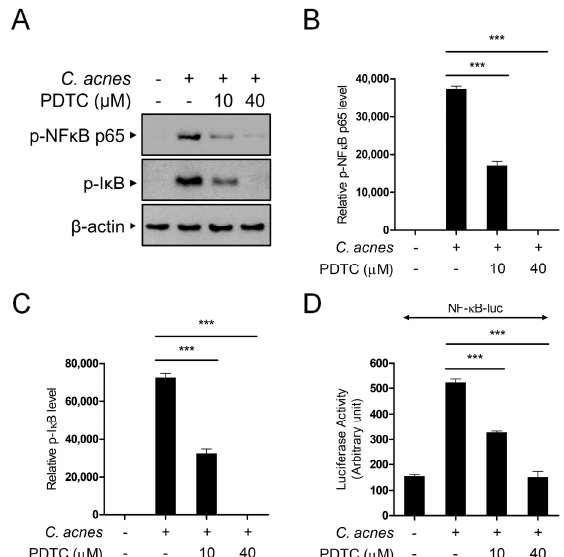
Figure 3. PDTC suppresses C. acnes -induced NF- κ B transcriptional activation. ( A – C ) Mouse BMDMs were pretreated with PDTC (10 µ M and 40 µ M) for 30 min and then incubated with heat-killed C. acnes (1 × 10 6 CFU/mL) for 30 min. p-NF- κ B (p65), p-I κ B, and β -actin protein levels were detected by Western blot analysis ( A ), and then the relative levels of protein bands were quantified ( B , C ). ( D ) RAW264.7 cells were transfected with the NF- κ B-luciferase reporter. After 24 h, the cells were pretreated with PDTC (10 µ M and 40 µ M) for 30 min and then incubated with heat-killed C. acnes (1 × 10 6 CFU/mL) for 6 h. The results are represented as the means ± SDs of three independent experiments. *** p < 0.001.